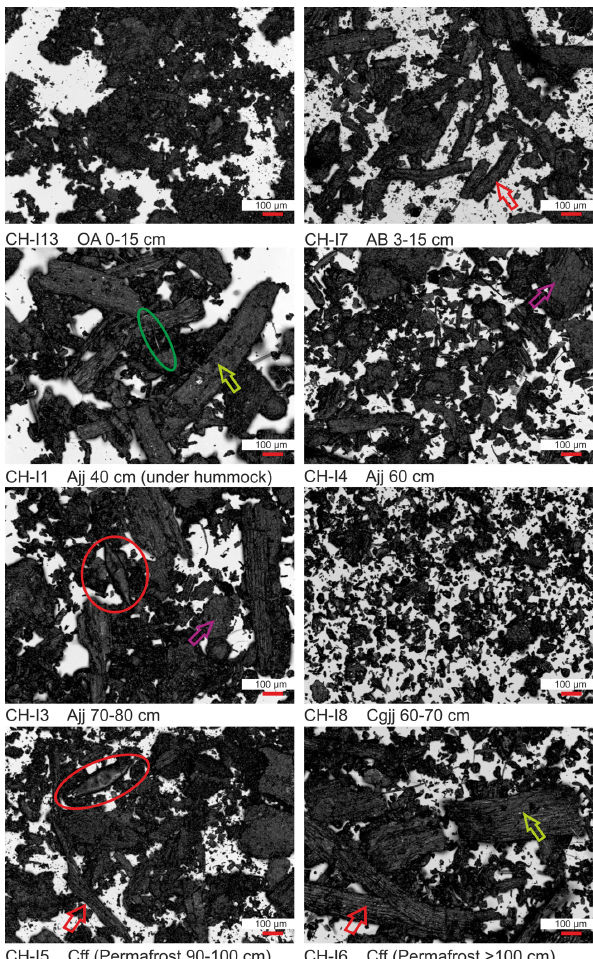
Figure 5. Laser scanning microscope images from the LF for one profile in western Siberia. The images were arranged according to the increasing soil depth of various genetic horizons. Red, green, and purple arrows denote fine roots, woody tissue, and bark, re- spectively. Red and green circles denote seeds and fungal hyphae,